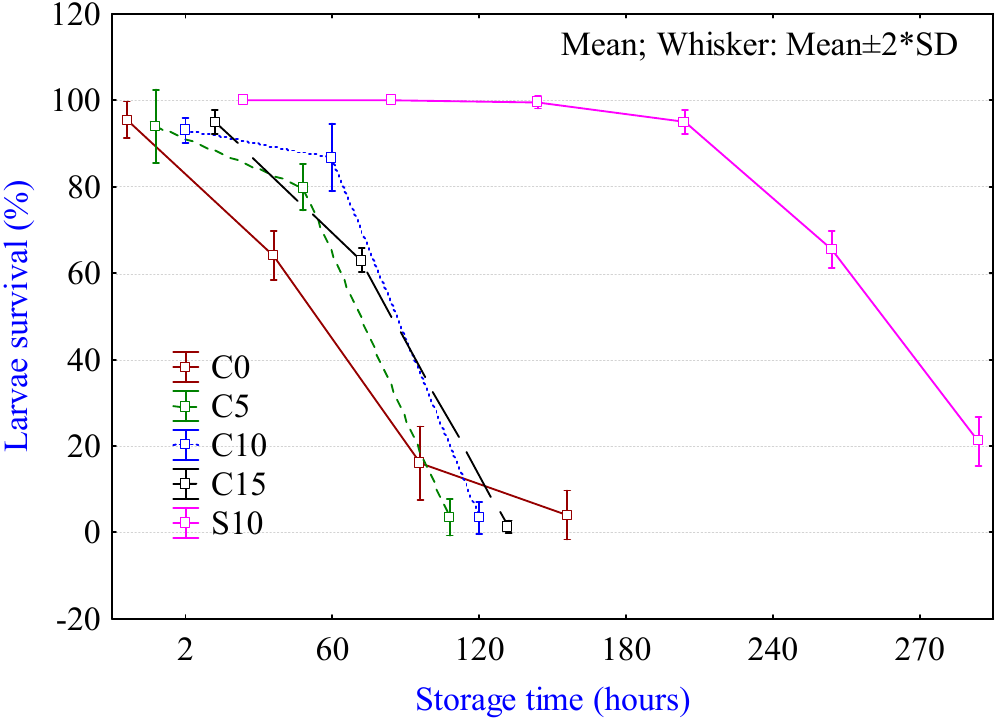
Figure 2. Survival of Anisakis spp. larvae exposed directly to fresh lemon juice (C0), lemon juice with addition of 5, 10, and 15% vol/vol acetic acid (C5, C10, and C15); and sugar solution (S10, 10 g/100 mL).